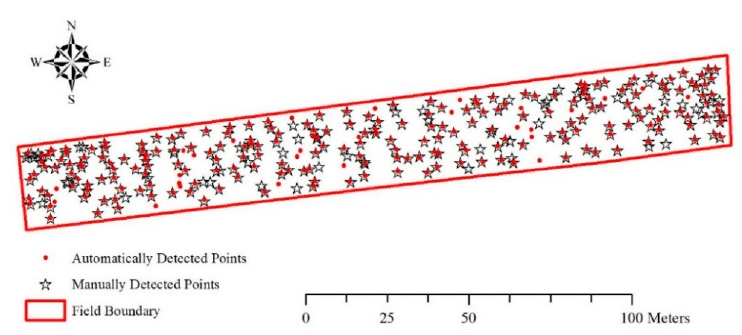
Figure 13. Field site I (powdery mildew disease detection map for site-specific management).